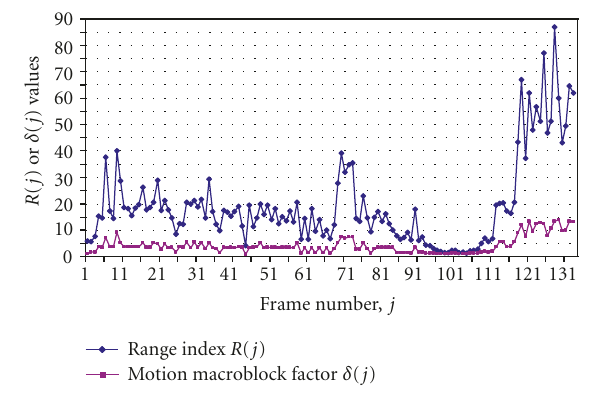
Figure 5: Motion macroblock factor and range index analysis for the “Foreman”